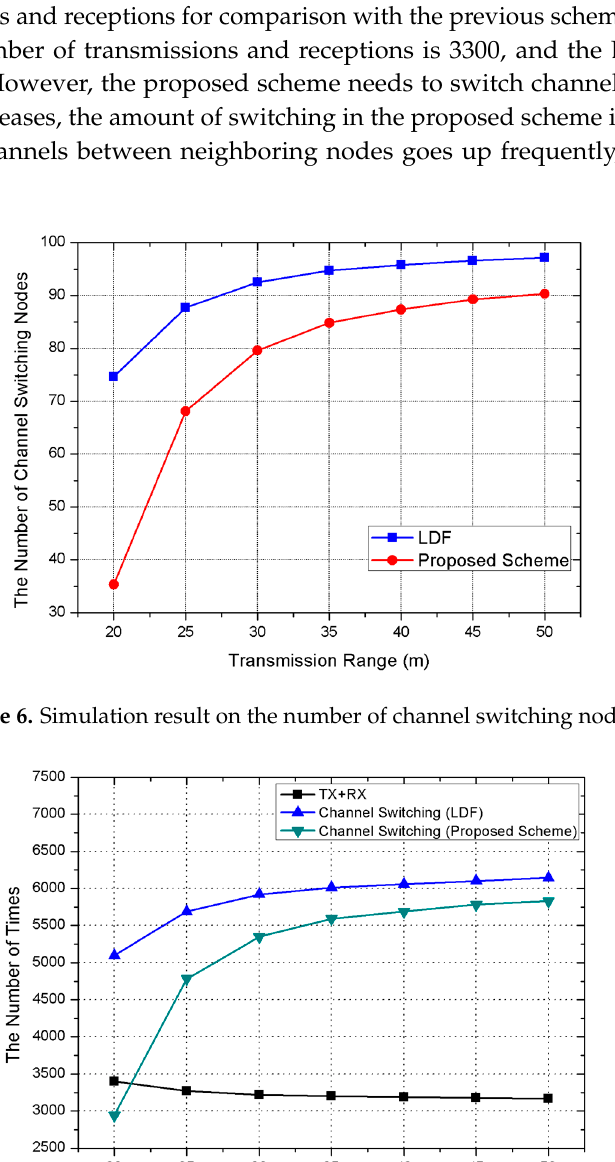
Figure 7. Simulation result on the number of switching and communication times.